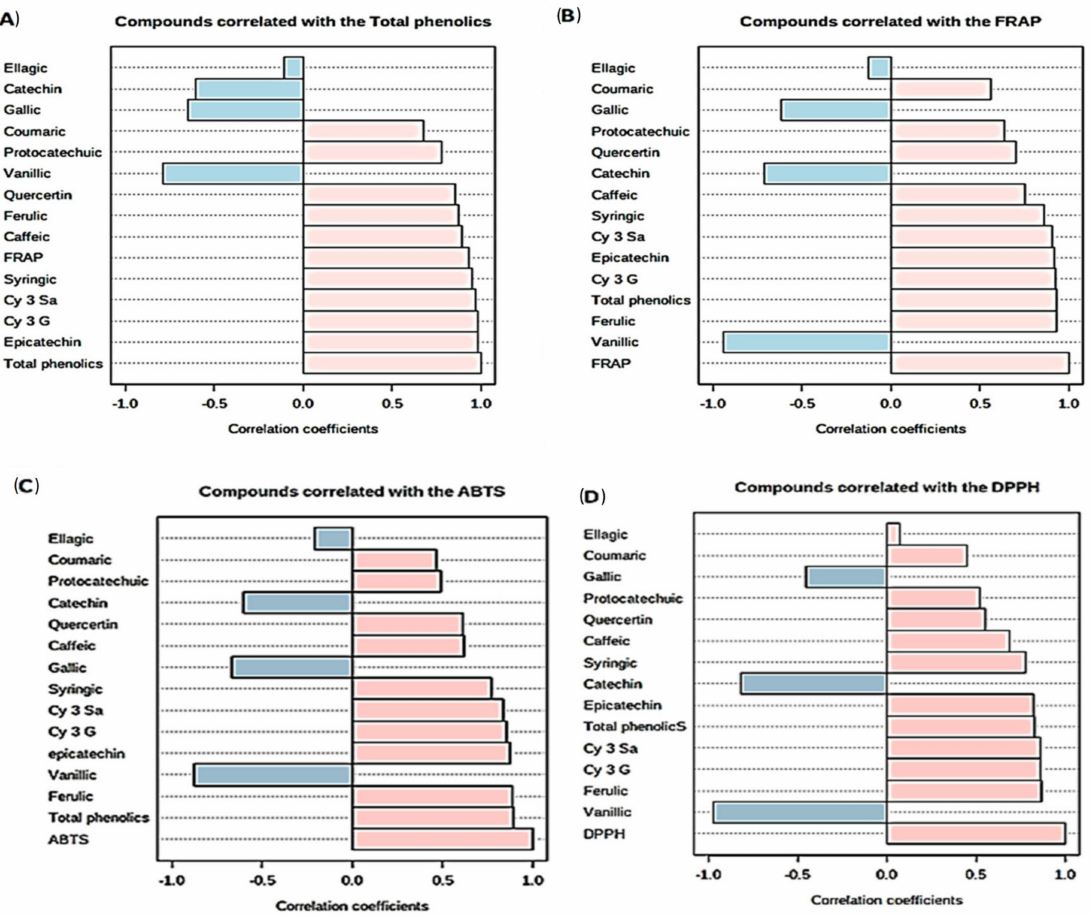
Figure 6. ( A – D ) Correlation of total phenolic content ( A ), FRAP antioxidant capacity ( B ), ABTS ( C ) and DPPH ( D ) radical scavenging capacities with phenolic